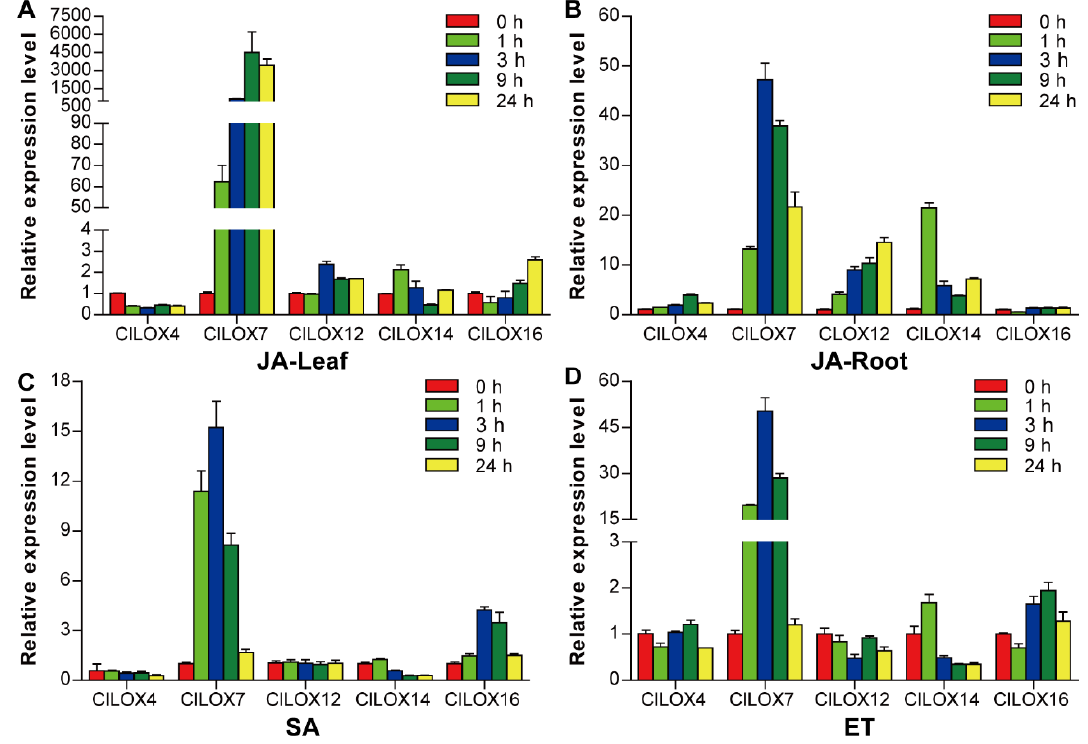
Figure 7. qRT-PCR analysis of the expression of selected ClLOX genes under various hormone treatments, including JA ( A , B ), SA ( C ), and ET ( D ). Error bars indicate standard deviation (SD) based on three biological replicates.